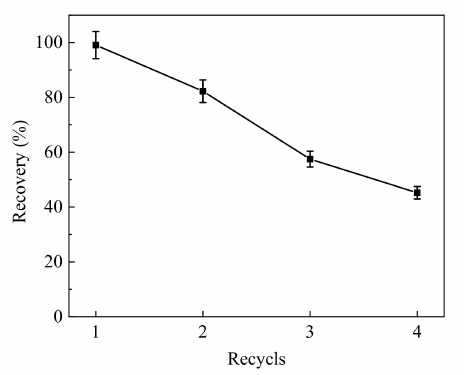
Figure 6. Regeneration experiment using Fe 3 O 4 @PPy composites for VD 3 adsorption.